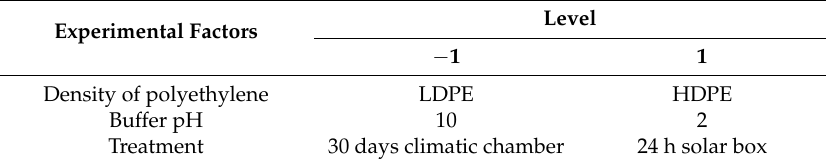
Table 1. Investigated experimental factors and levels experimental